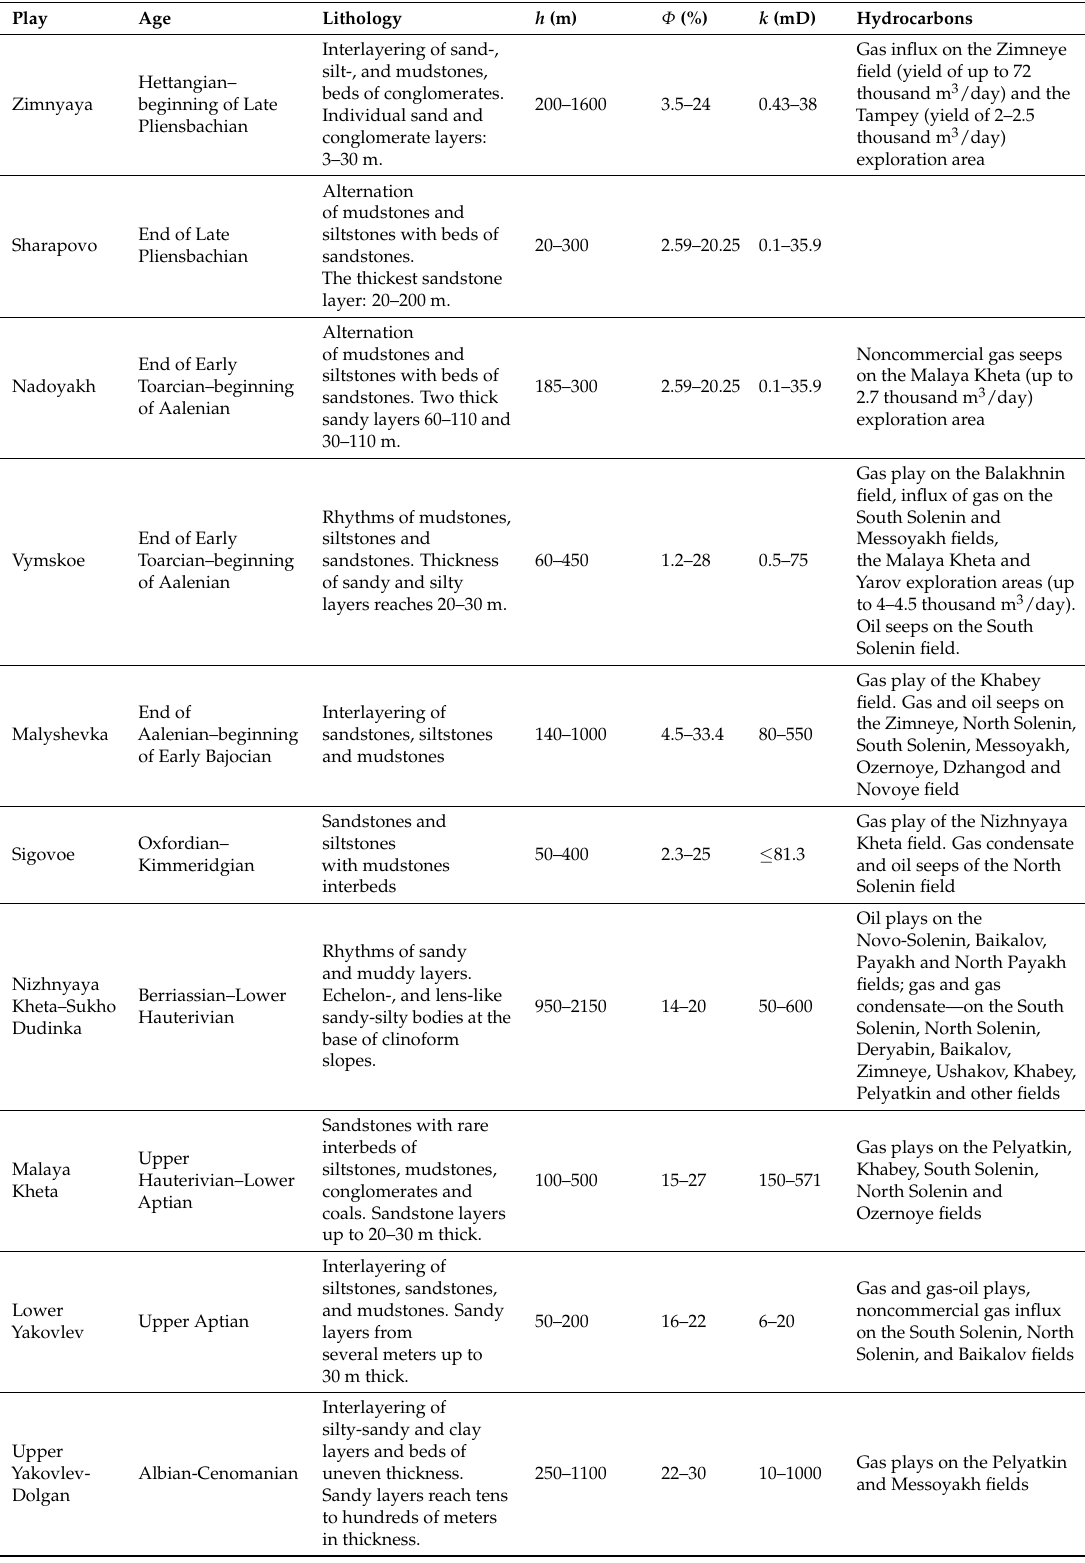
Table 1. Play characteristics in the Jurassic–Cretaceous sedimentary infill of the Yenisei-Khatanga basin. Compiled using References